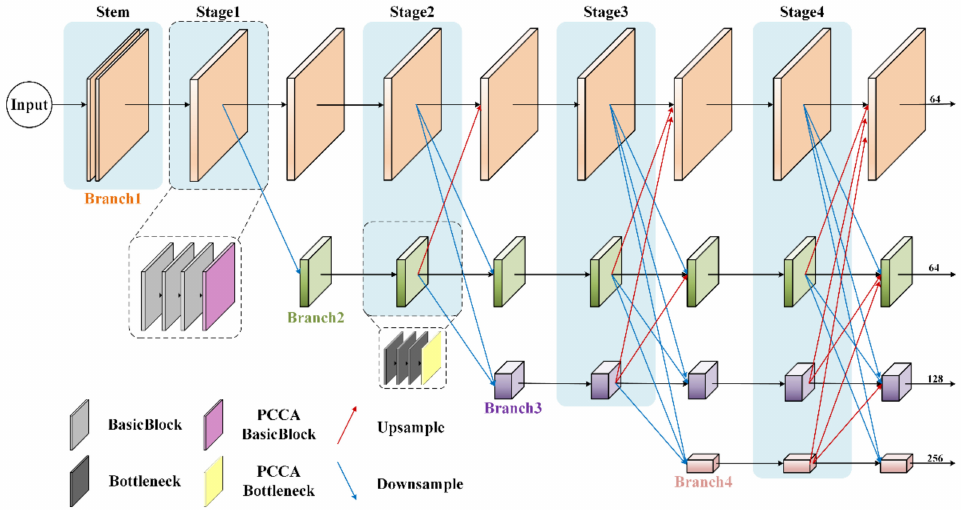
Figure 8. The architecture of the new backbone.